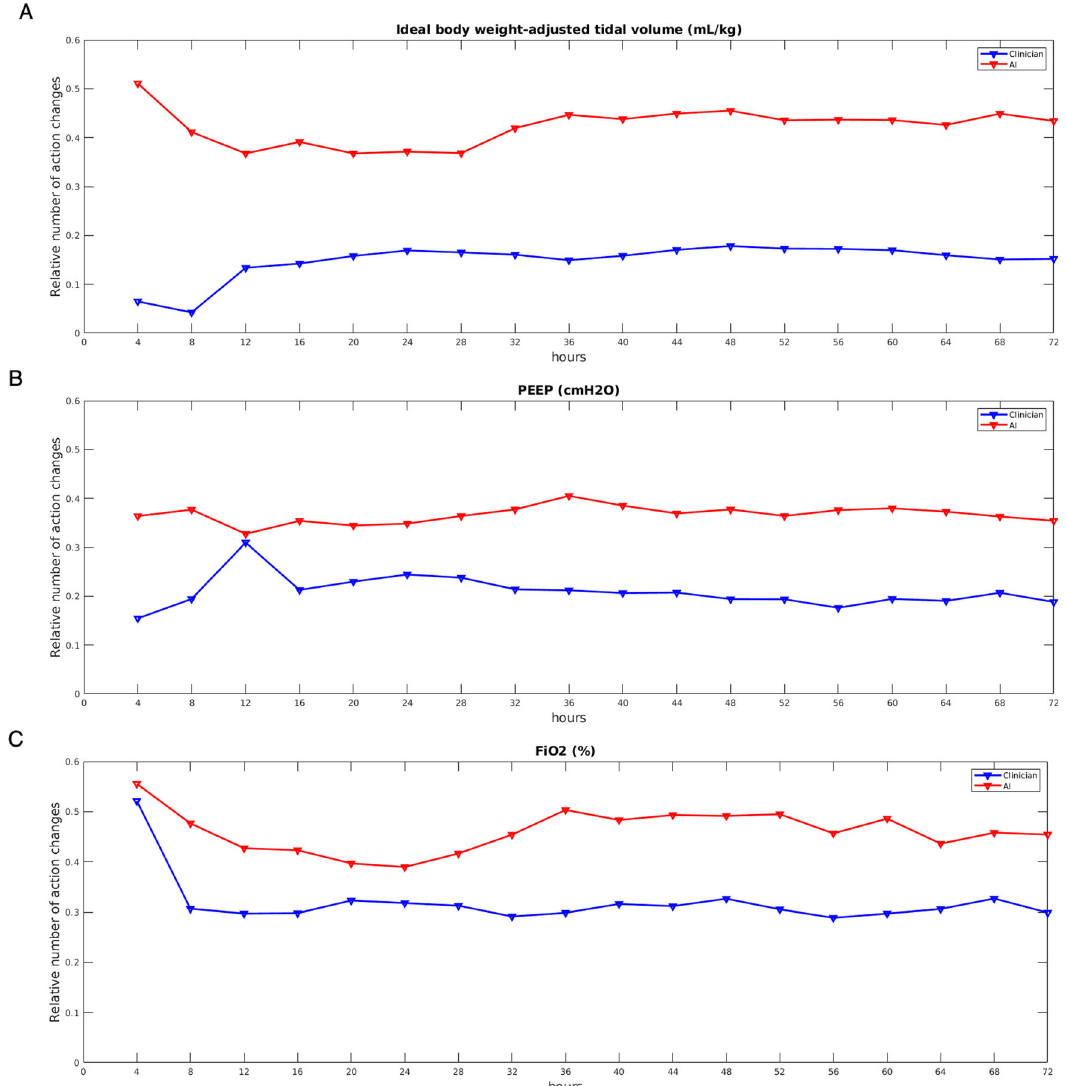
Fig. 4 Number of action changes (MIMIC-III dataset). The relative number of action changes (ideal body weight-adjusted tidal volume (Vt), positive end expiratory pressure (PEEP), and fraction of inspired oxygen (FiO 2 )) is shown in relation to the number of mechanically ventilated patients at each 4 h time step. Clinicians action changes are shown in blue while the VentAI action changes are shown in